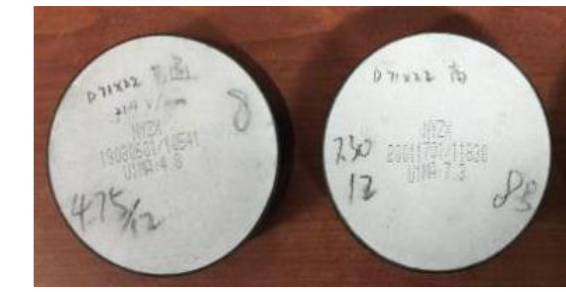
Figure 3. Test tooling and two kinds of arrestor valves.